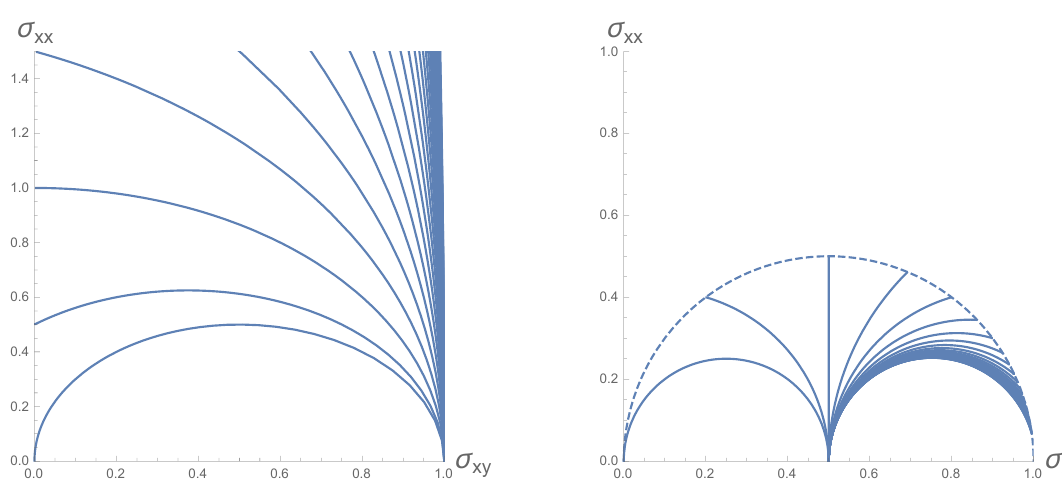
Figure 1 . (Left) Phase diagram of the flow in the space of conductivities fills the fundamental domain of the upper half plane in units of ˆ σ = ρ/B . Different curves correspond to different bare values ζ of σ . The bare value of σ is set to zero ( W = 0 ). (Right) The flow diagram of the xx xy theory upon the STS